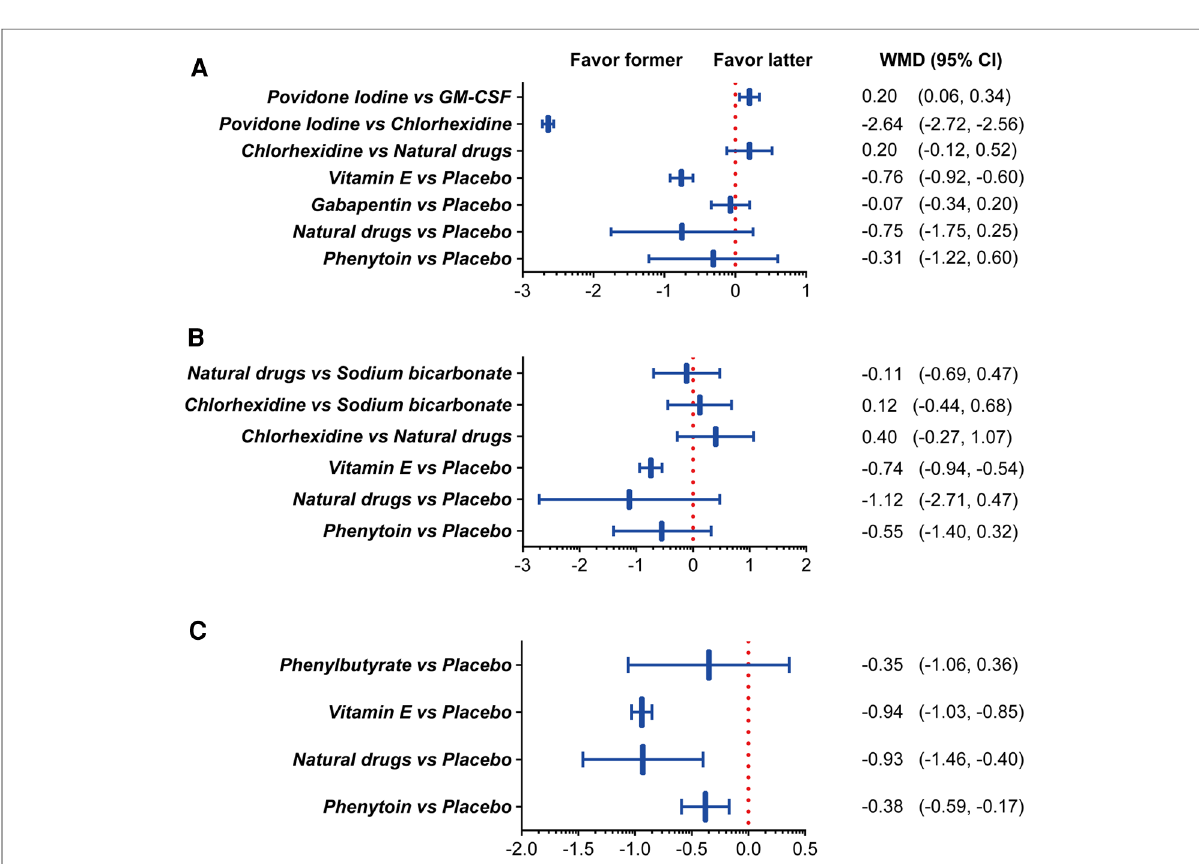
FIGURE 5 Combined forest plots showing comparisons between the mouthwash types based on their OM score improvement after one ( A ), two ( B ), and three ( C ) weeks of treatment. Abbreviations: CI, con fi dence interval; GM-CSF, granulocyte-macrophage colony-stimulating factor; WMD, weighted mean difference. Note: Natural drugs in Figure A include Achillea extract, Althaea root extract, Plantago major extract, Curcumin, and Royal jelly; in Figure B include Achillea extract, Althaea root extract, Plantago major extract, and Royal jelly; in Figure C include Achillea and